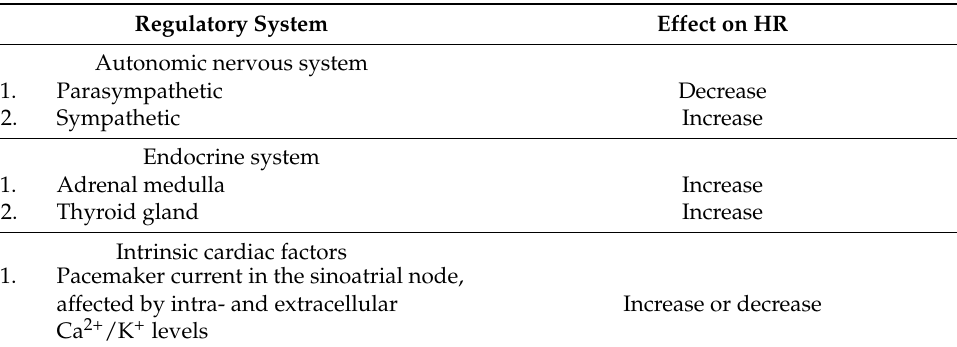
Table 1. Major regulators of the heart rate in normal conditions.